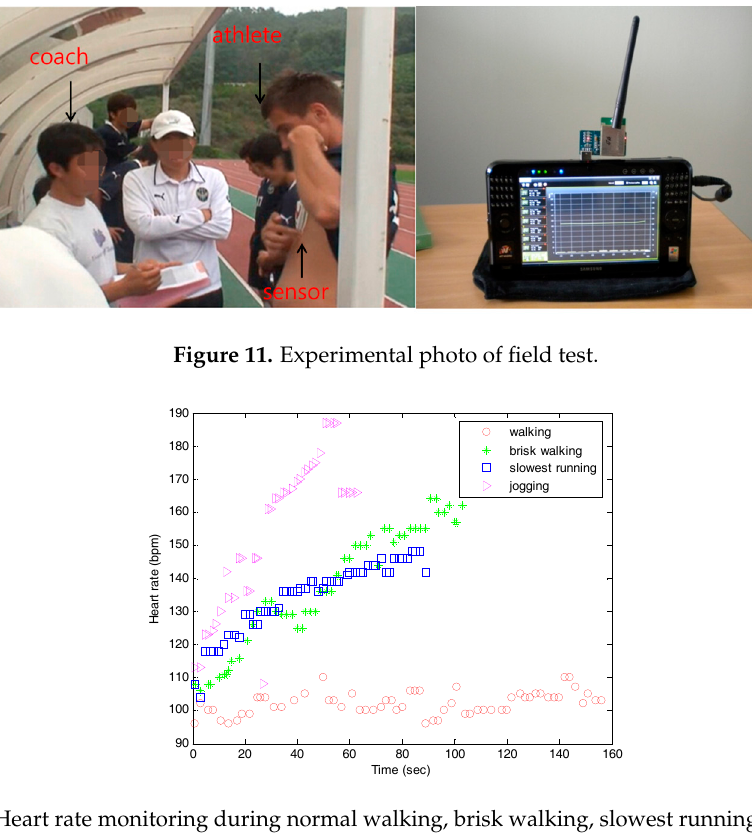
Figure 12. Heart rate monitoring during normal walking, brisk walking, slowest running, and jogging in an open field test.